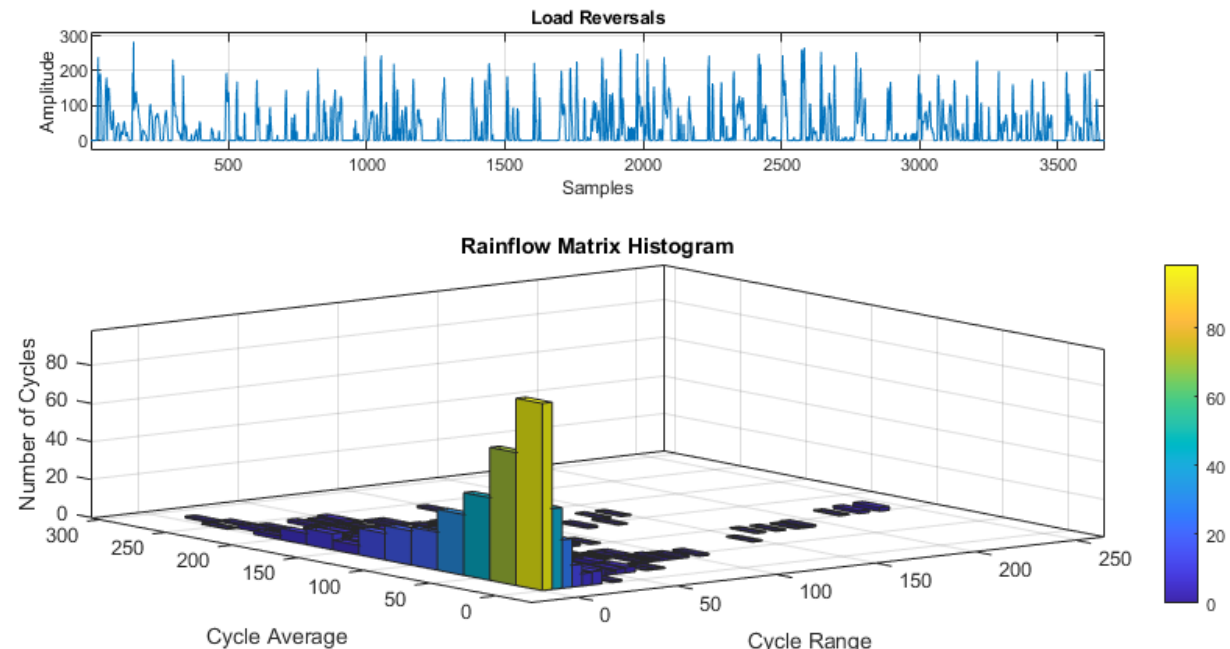
Figure 16. Rainflow histogram of the ICE vehicle model torque history.